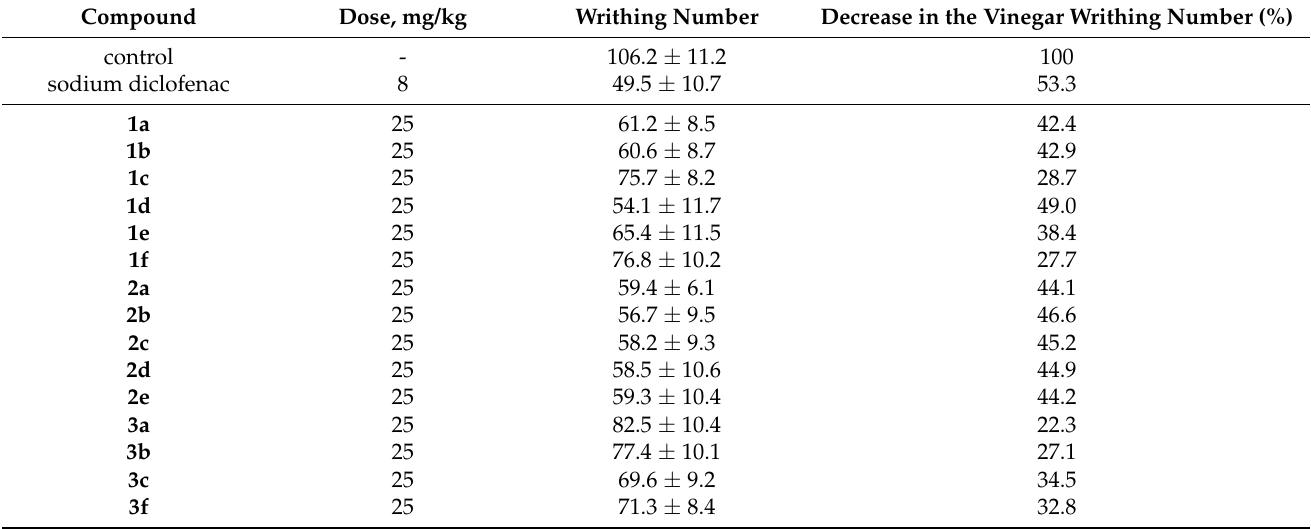
Table 4. Analgesic activity of test